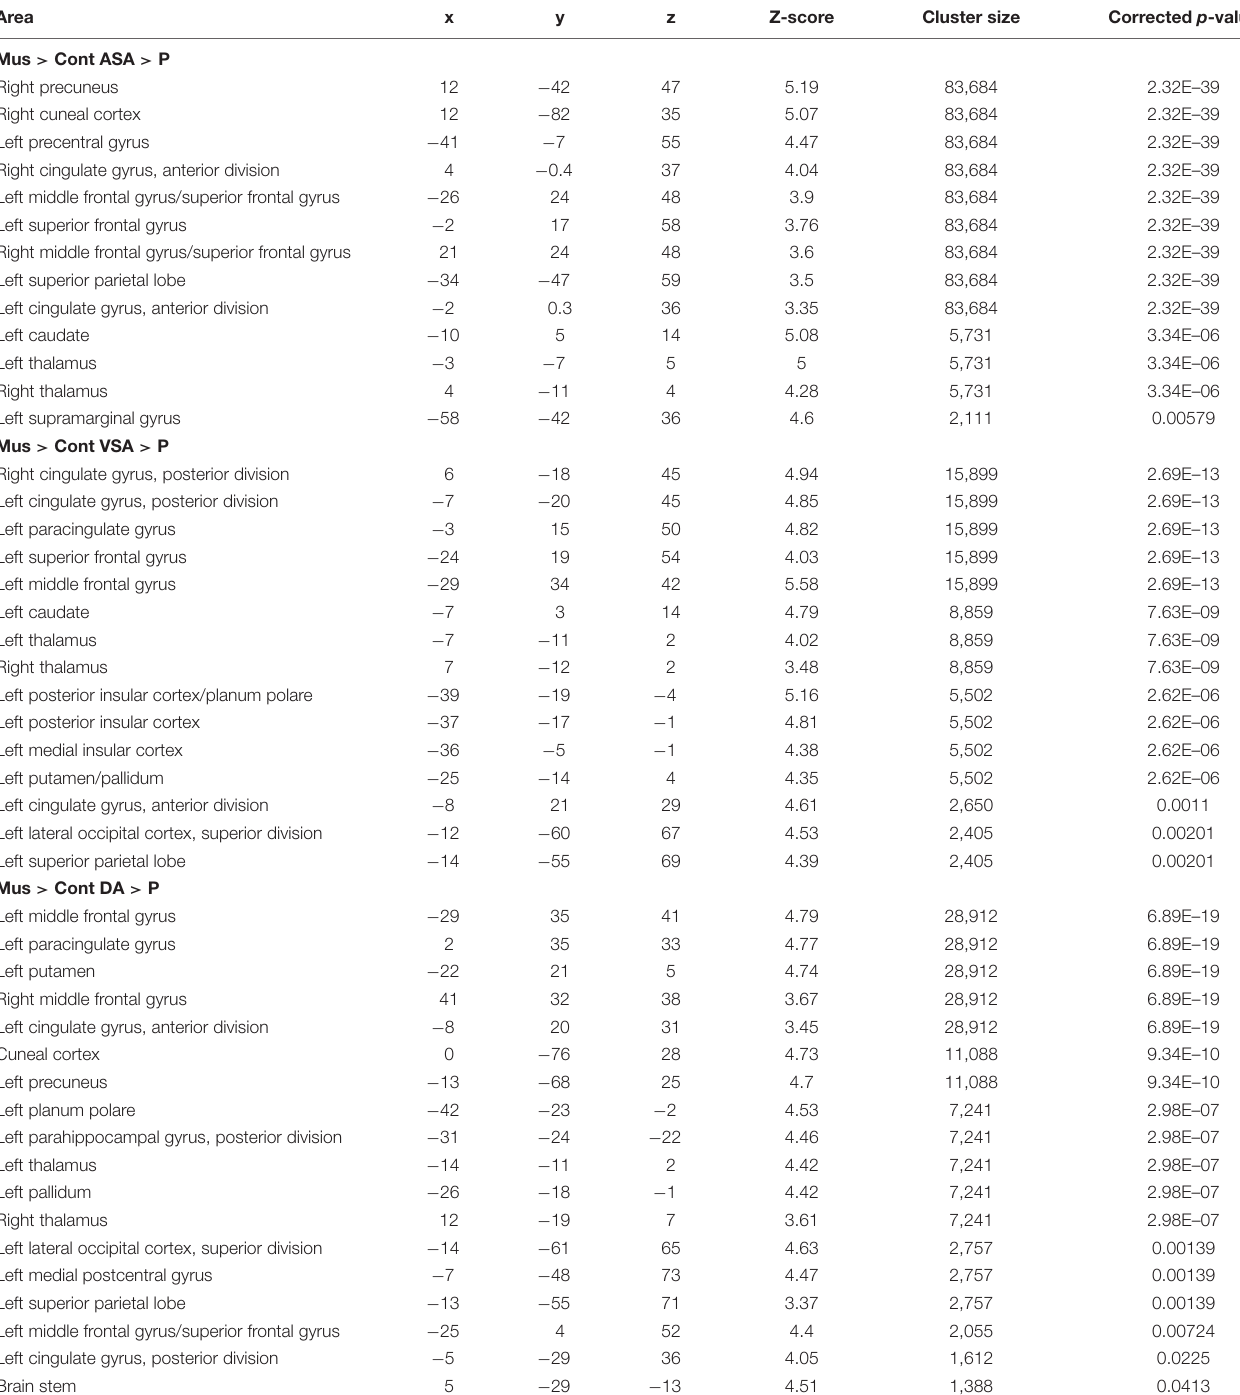
TABLE 4 | Peaks of activity of group differences (Mus > Cont children) for the encoding phase contrasts [ASA > P], [VSA > P], and [DA > P]. Area x y z Z-score Cluster size Corrected p